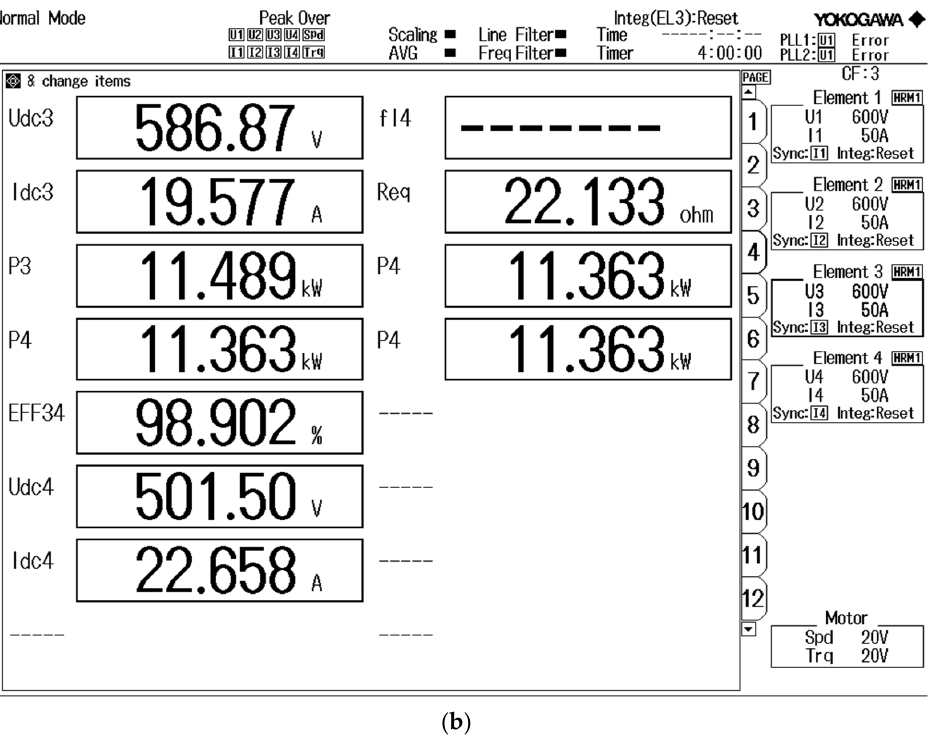
Figure 14. Multiphase buck converter at rate power. ( a ) Upper Insulated Gate Bipolar Transistor (IGBT) voltages and inductor currents; ( b ) Power analysis result. Ch1: first phase upper IGBT voltage; Ch2: second phase upper IGBT voltage; Ch3: first phase inductor current; Ch4: second phase inductor current.